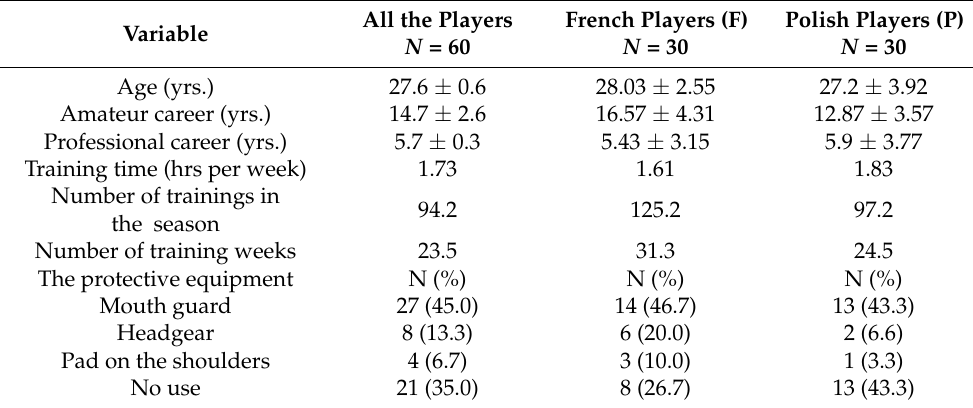
Table 1. General characteristics of the rugby players ( n = 60).